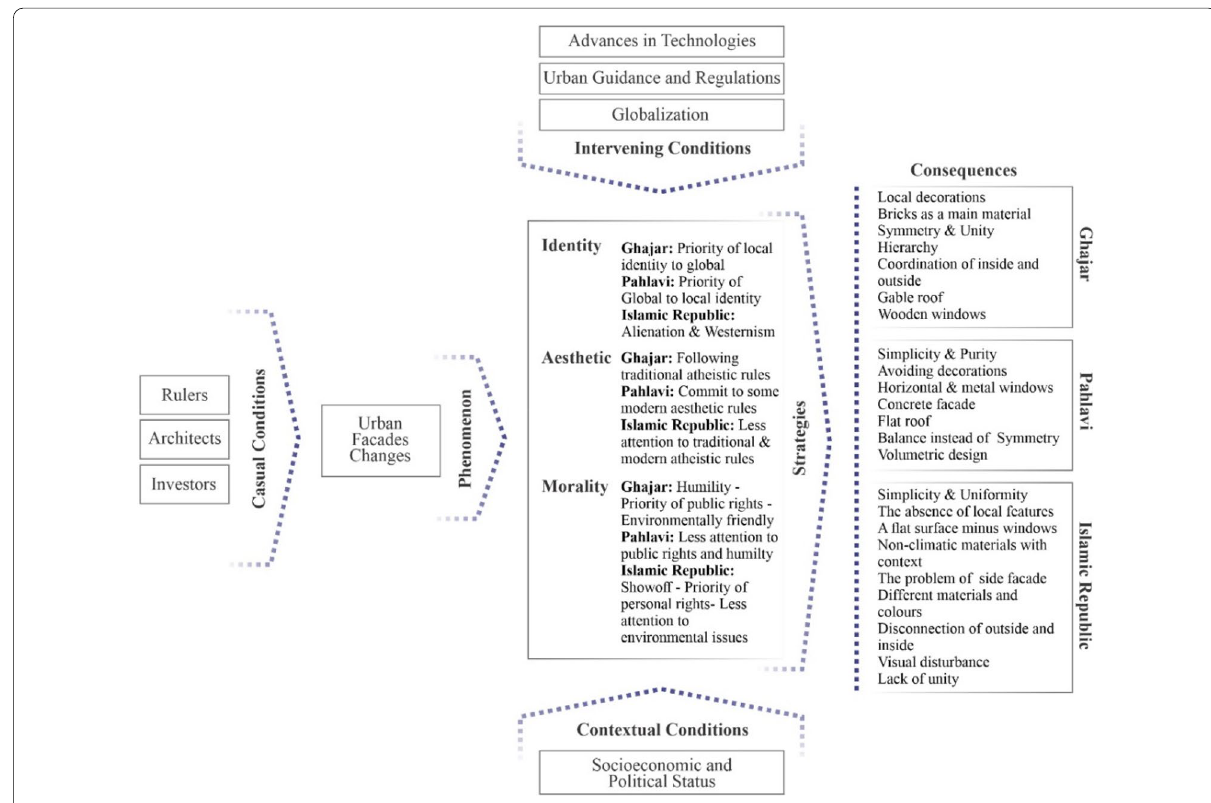
Fig. 6 The paradigmatic model of the transformation of urban